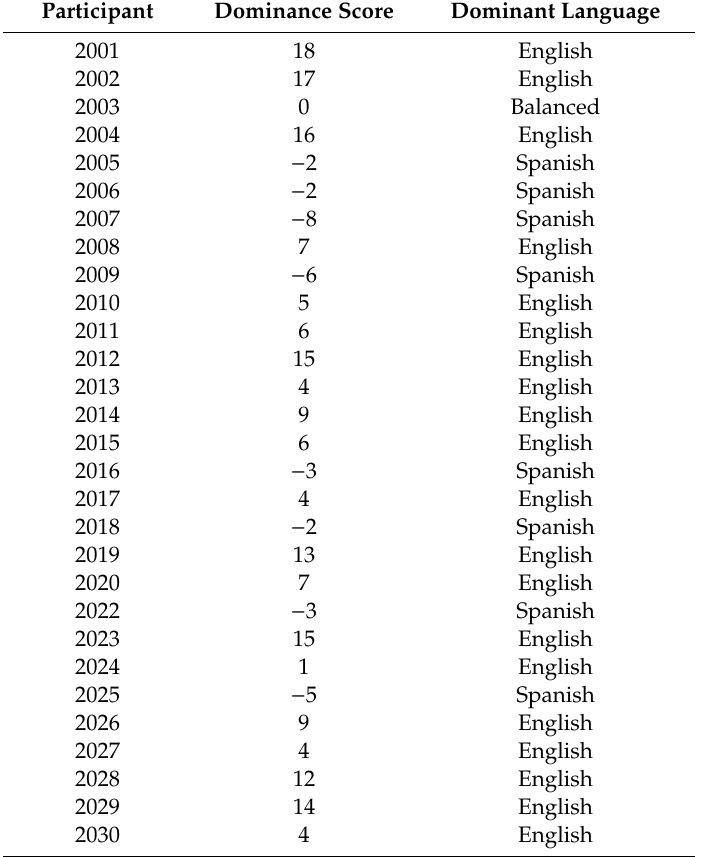
Table A2. Bilingual Dominance Scale (BDS) individual dominance scores on a scale from − 32 (Spanish) to 32